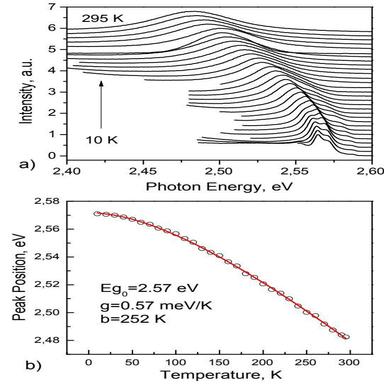
Temperature evolution of the excitonic emission (a) and the dependence of its maximum (circles) with theoretical fitting (red line) performed with Eq. (b) for CdS crystal.